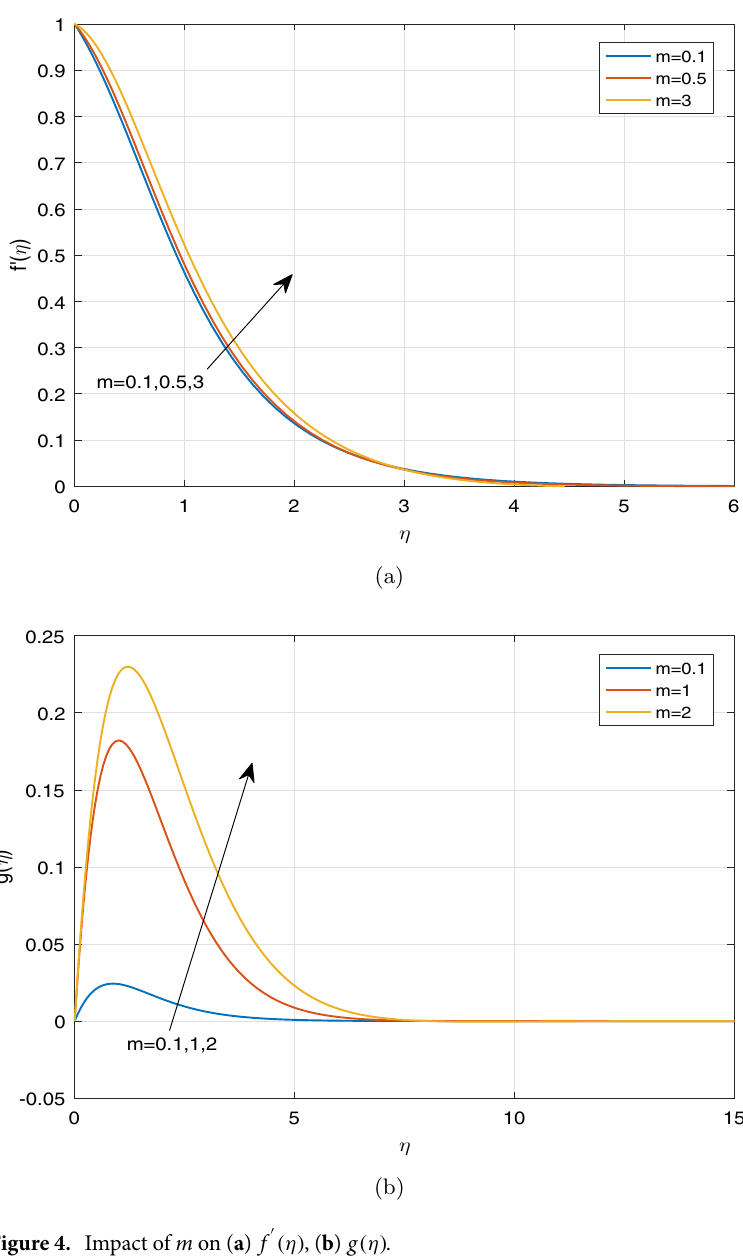
Figure 4. Impact of m on ( a ) f ′ (η) , ( b ) g (η)